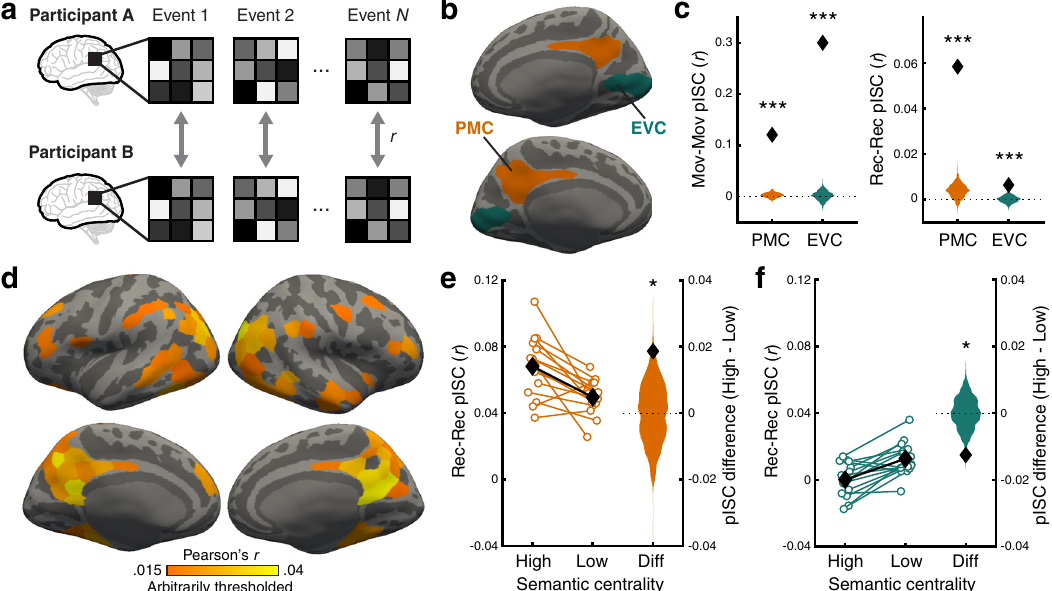
Fig. 4 Event-speci fi c intersubject pattern correlation. a Intersubject pattern correlation (pISC) was computed for each movie event by correlating the event-speci fi c activation pattern (averaged across times within the event) of a participant and that of each of the other participants. b Posterior medial cortex (PMC; orange) and early visual cortex (EVC; green) regions-of-interest visualized on the in fl ated surface of a template brain (medial view). c pISC in PMC and EVC during movie watching (left) and recall (right). Black diamonds show the mean pISC averaged across all participants and movie events. Orange and green histograms show the null distributions of the mean pISC in PMC and EVC, respectively. Statistical signi fi cance re fl ects difference from zero based on one-tailed randomization tests (all p s = .000999). d Whole-brain surface map of mean pISC during recall. pISC was computed for each of 400 parcels in a cortical atlas 33 . The pISC map was arbitrarily thresholded at r = .015 for visualization purposes. pISC values in all visualized parcels were signi fi cantly greater than zero based on randomization tests (FDR-corrected q < .05 across parcels). e , f pISC for High vs. Low semantic centrality events during recall and the difference (Diff) between the two conditions in PMC ( e ) and EVC ( f ). For High and Low semantic centrality conditions, white circles represent individual participants ( N = 15). Black diamonds represent the mean across participants within each condition. Error bars show SEM across participants. For the difference between High and Low conditions (Diff), black diamonds show the true participant average, and histograms show the null distribution of the mean difference. Statistical signi fi cance re fl ects difference from zero based on two-tailed randomization tests ( p = .037 and .012 in PMC and EVC, respectively). * p < .05, *** p < .001. Source data for c , e , and f are provided as a Source Data fi